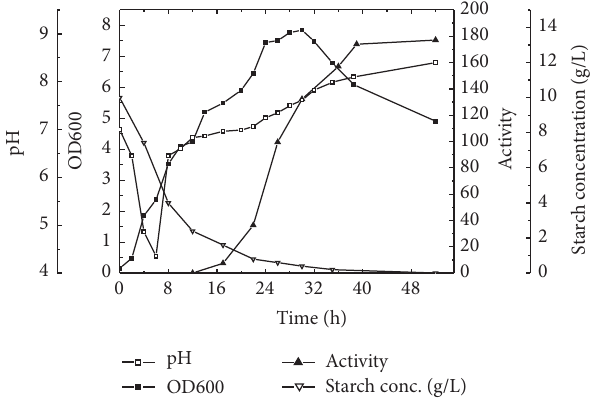
F 1: Time course of growth and licheniformis AI20 isolate in basal